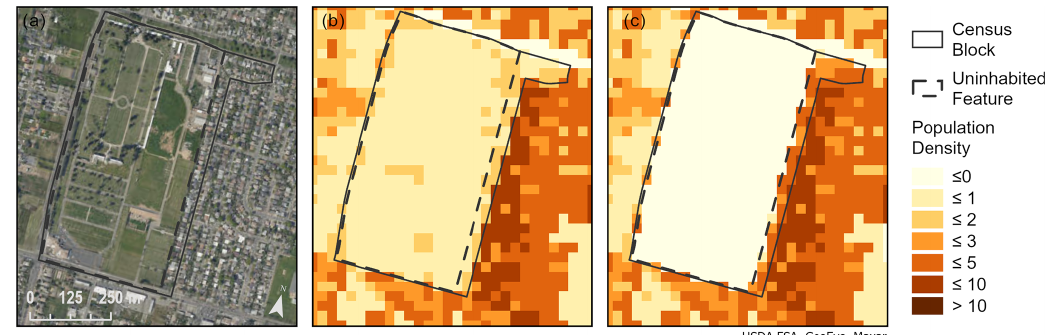
Figure 6. A census block near Sacramento, California, with a cemetery (i.e., uninhabited feature) covering most of the block and residential housing along the eastern border (a) . IDM results with the 2016 specification of uninhabited (b) have population throughout the block while IDM results with the updated specification of uninhabited (c) have zero population for the cemetery and denser population along the eastern